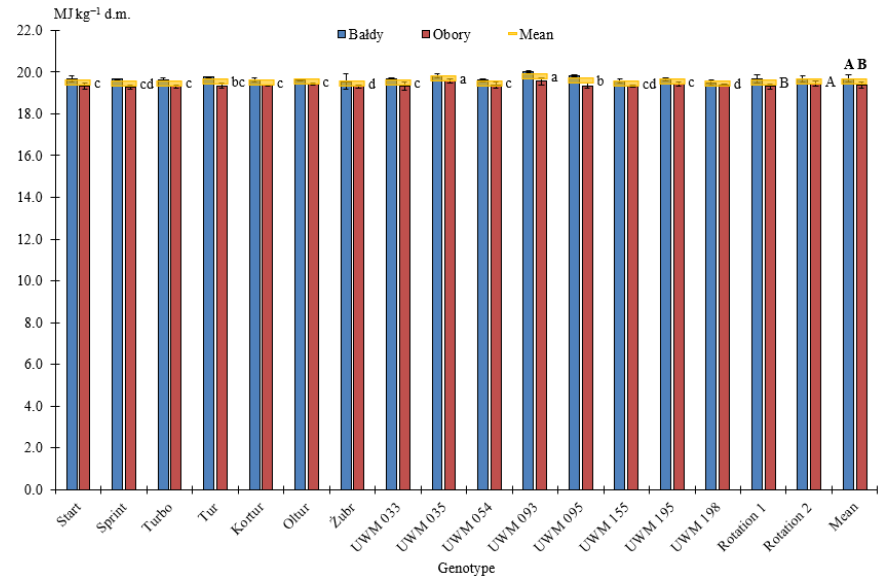
Figure 5. Higher heating value (HHV) of the biomass of 15 willow genotypes obtained at two locations in two consecutive three-year harvest rotations; (legend: see Figure 1).